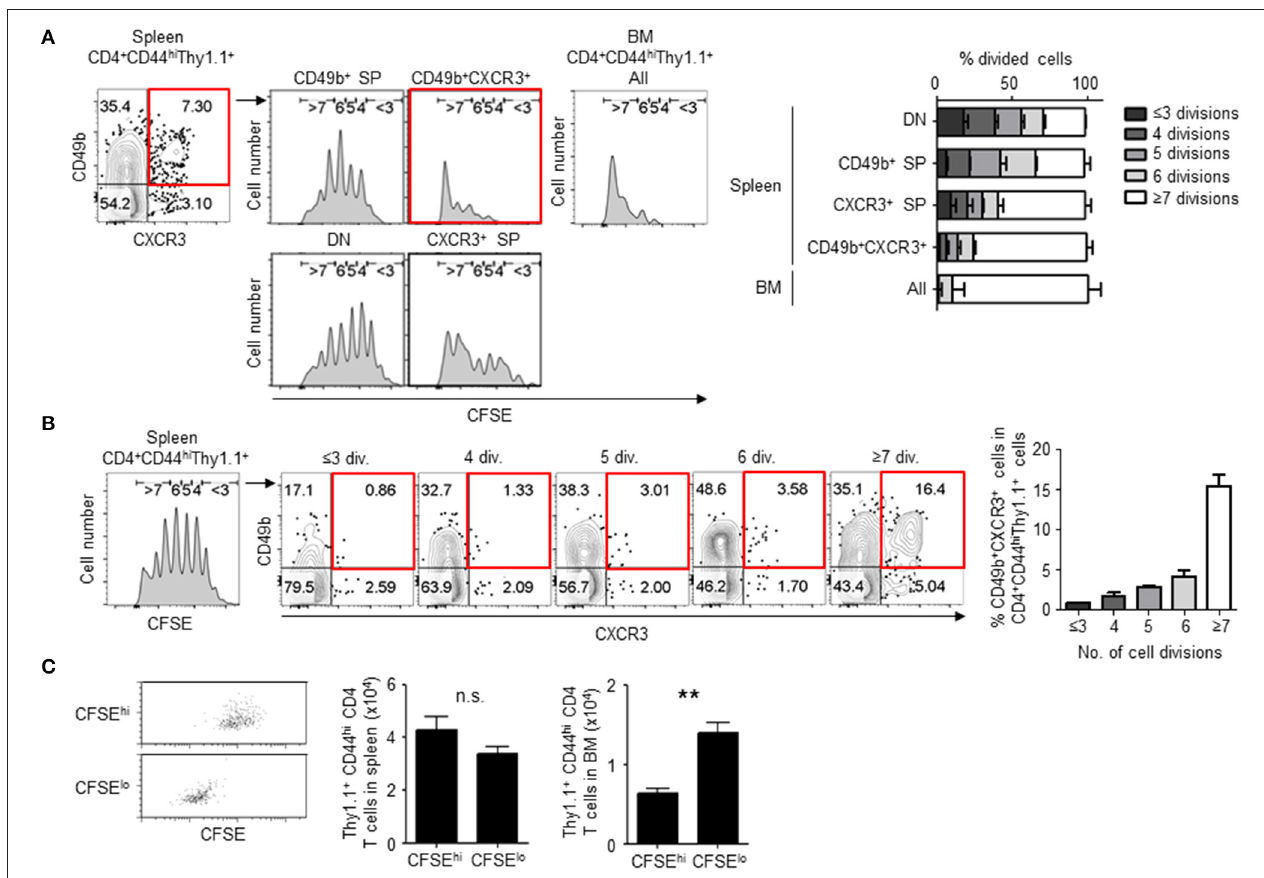
FIGURE 1 | CD49b ± CXCR3 ± memory precursors exhibit enhanced cell division. Purified CFSE-labeled Thy1.1 + LCMV GP-specific CD4T cells were transferred intravenously into C57BL/6 mice followed by intraperitoneal immunization with 100 µ g LCMV-gp61 and 10 µ g LPS, and analyzed on day 5 after immunization by flow cytometry. (A) Numbers of cell divisions in activated CD4T cell subpopulations. A gating plot displays subsets defined by expression of CD49b and CXCR3 within Thy1.1 + CD4 + CD44 hi B220 − NK1.1 − PI − cells in the spleen and all subpopulations in the BM. Histograms display the dilution of CFSE in each subpopulations. Gates in histograms indicate the rounds of divisions that CFSE-labeled cells have undergone by day 5. A bar chart represents the percentages of each CFSE-diluted population n = 6. (B) Frequencies of the CD49b + CXCR3 + subpopulation in splenic activated CD4T cells that have undergone the indicated numbers of cell divisions (div.) n = 6. (C) Highly divided CD4T cells preferentially migrate into the BM. CFSE hi and CFSE lo cells were sorted from activated CD4T cells on day 5 after immunization as described above, transferred into RAG1-deficient mice and 2h later analyzed for Thy1.1 + cell numbers in the spleen and BM of host mice. The transfer efficiency was compensated by co-transferred Ly5.1 + splenocytes. Dot plots show the dilution of CFSE after sorting n = 4. These data are representative of two or more independent experiments. Data are shown as mean ± SD. ** p < 0.01, n.s.: not significant. SP, single positive; DN, double